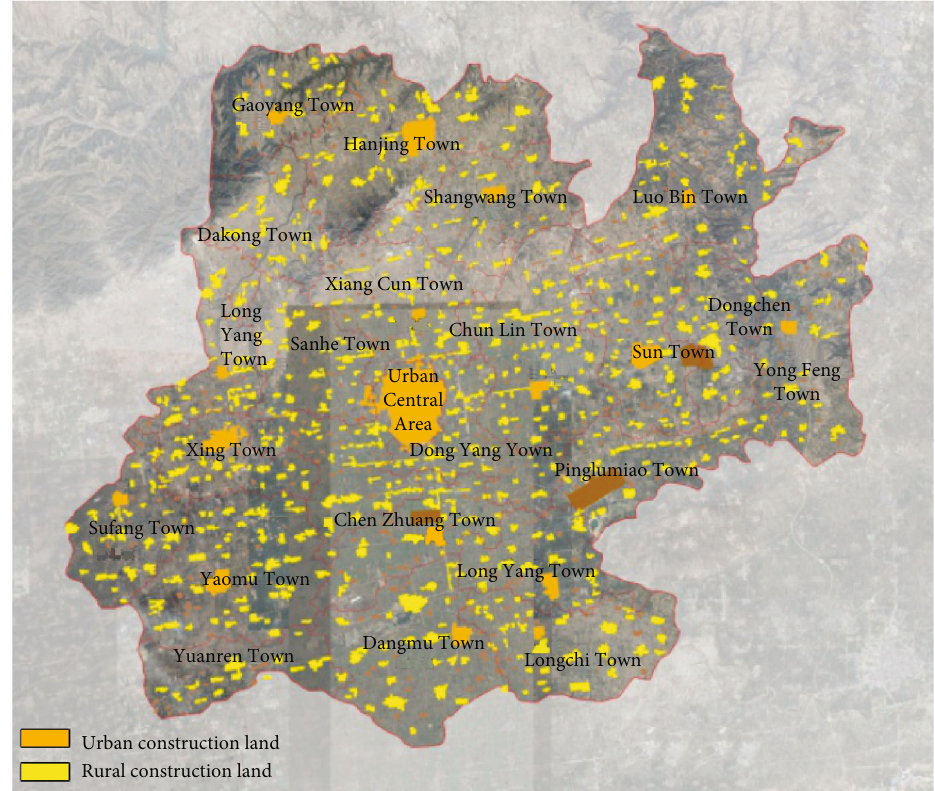
Figure 2: A map of urban and rural construction land in Pucheng in